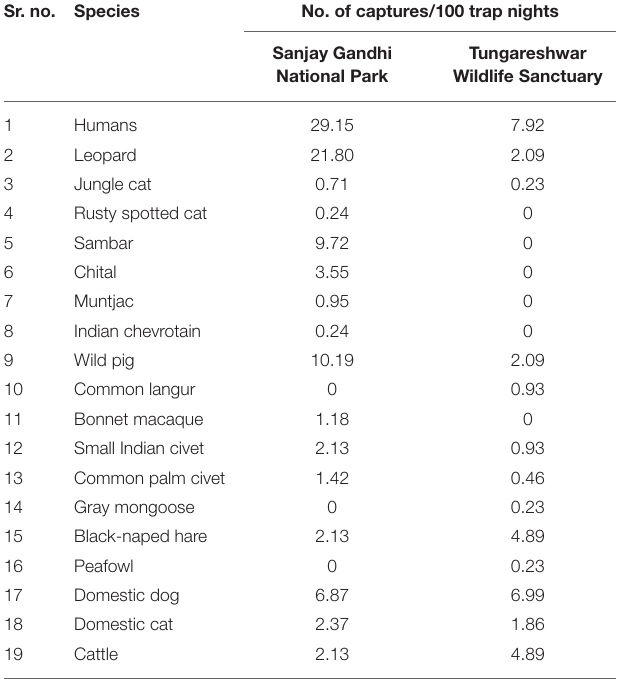
TABLE 2 | Photo-capture rates of species photo-captured in Sanjay Gandhi National Park and Tungareshwar Wildlife Sanctuary in 2015 and 2016,